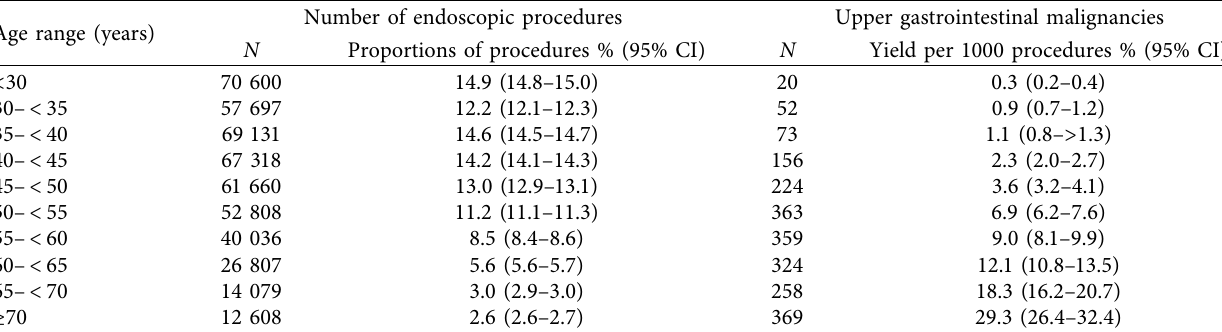
Table 4: Yield of esophagogastroduodenoscopy for upper gastrointestinal malignancy with prompt endoscopy strategy. Number of endoscopic Age range (years)